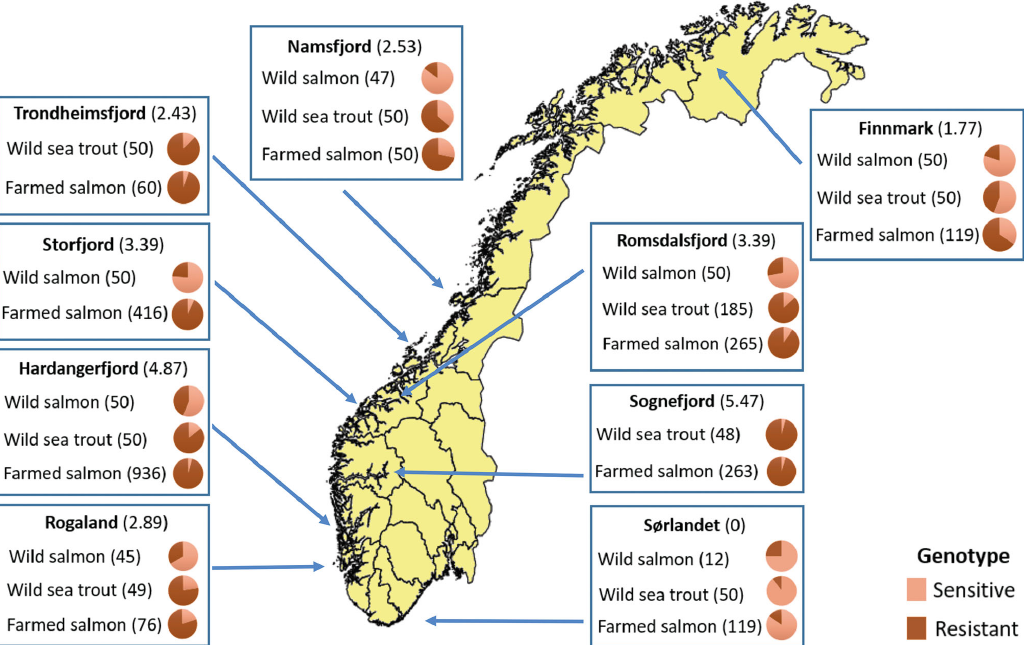
Fig. 3. Genotype (resistant or sensitive) frequency of the pyrethroid resistance marker in salmon lice sampled from wild At- lantic salmon, wild sea trout and farmed salmon along the Norwegian coast in 2014. These data are based on analysis of 826 lice from wild and 2304 lice from farmed salmonids. The number of salmon lice tested from each host within each region is given in parenthesis. The accumulated treatment index for the years 2012 to 2014 is given in parenthesis after the name of each region. The background map is derived from Global Administrative Areas (2012) and R packages (Becker & Wilks 1993, 1995, Pebesma & Bivand 2005, Bivand et al.